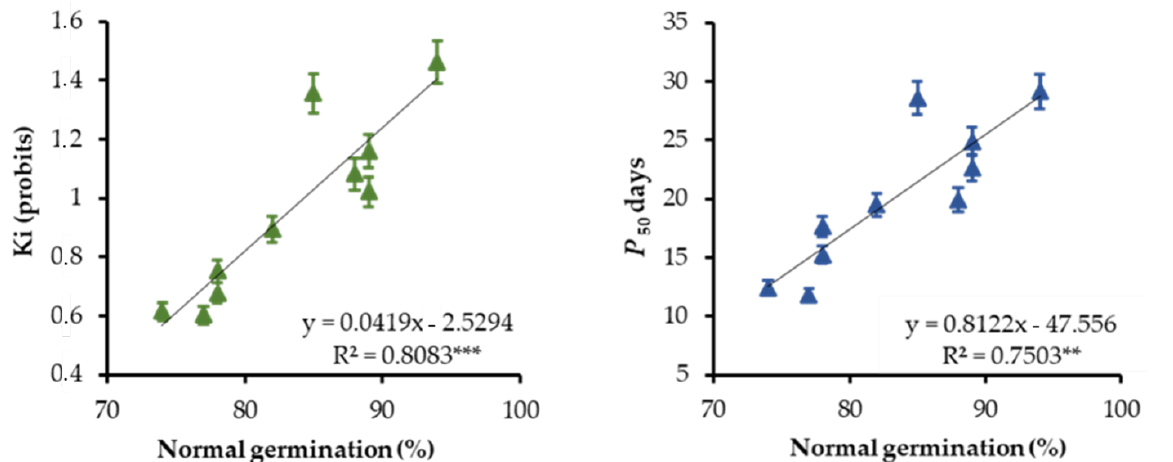
Figure 4. Correlation between the normal germination of pre-storage standard laboratory germination and storage parameters, Ki and P 50 , for seeds of ten onion ( Allium cepa L.) seed lots. Values were derived from Tables 1 and 2. Significance: **: 0.01, ***: 0.001.